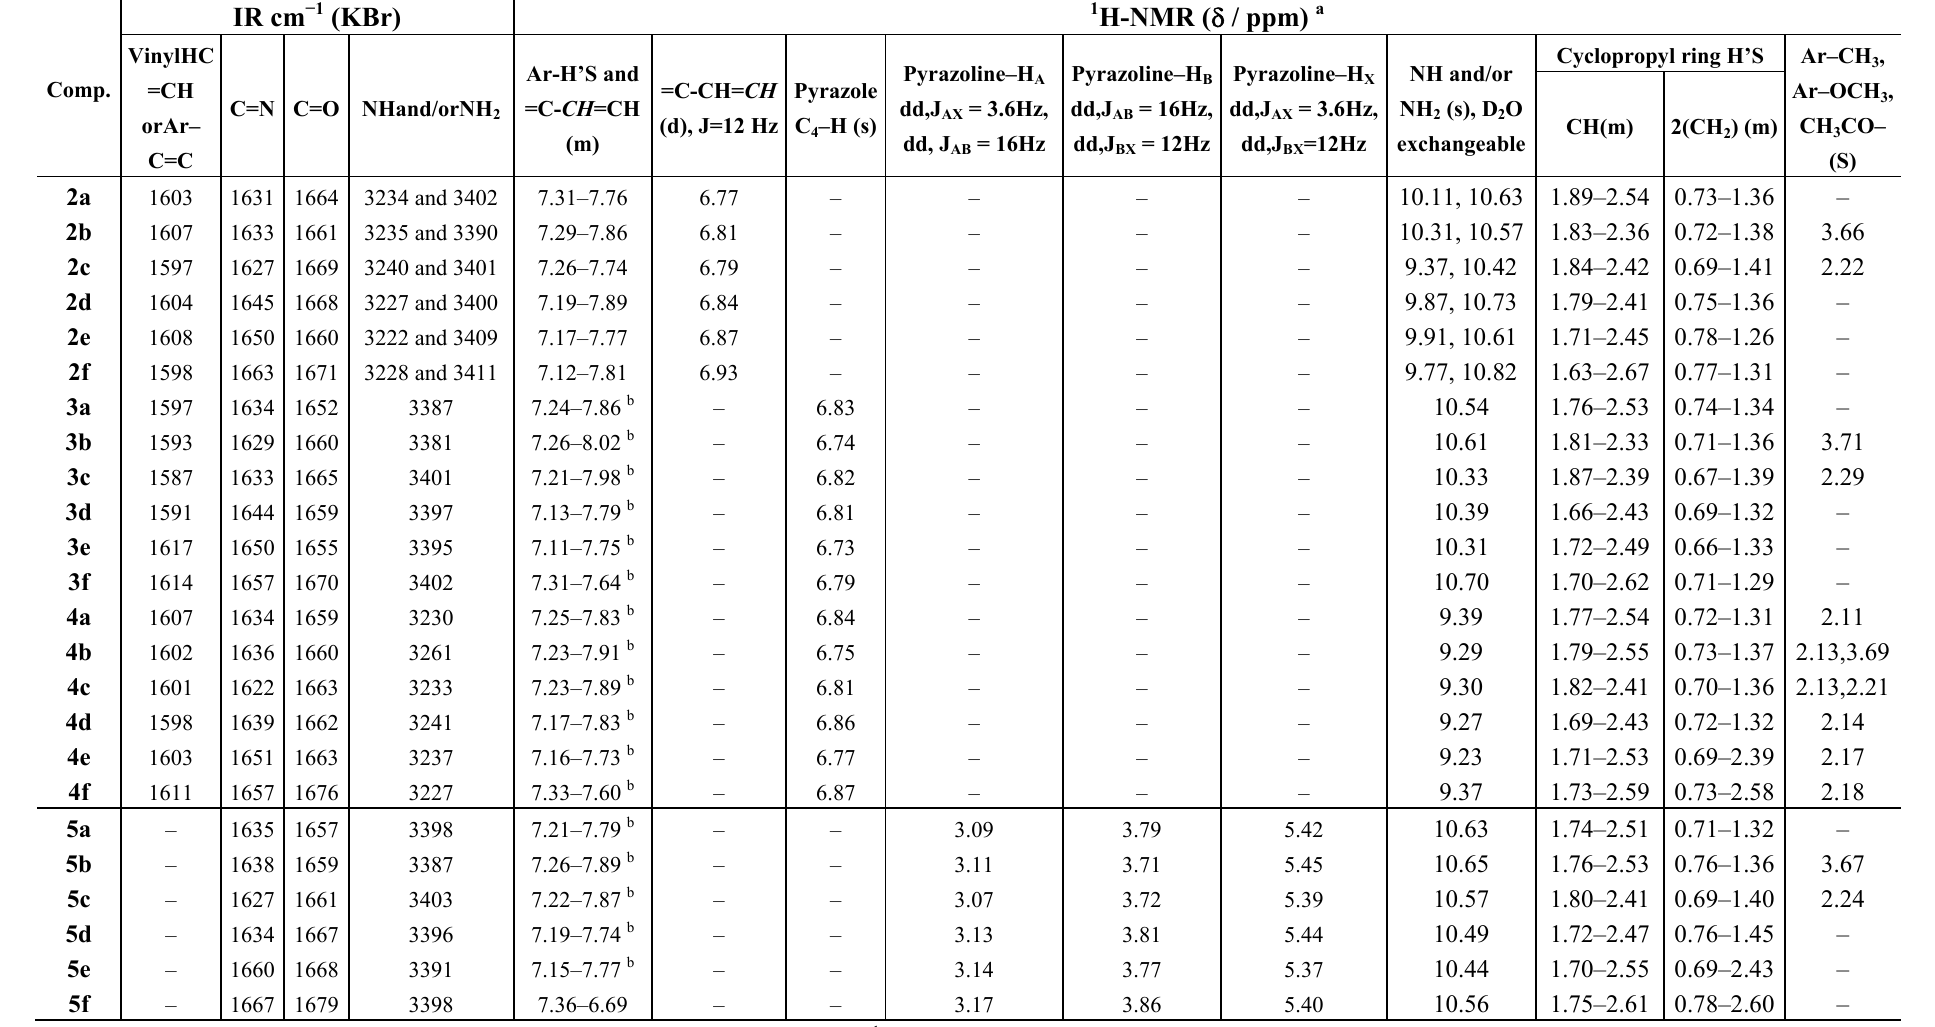
Table 2. IR and 1 H-NMR Spectral Data of Compounds 2a-f, 3a-f, 4a-f, and 5a-f .